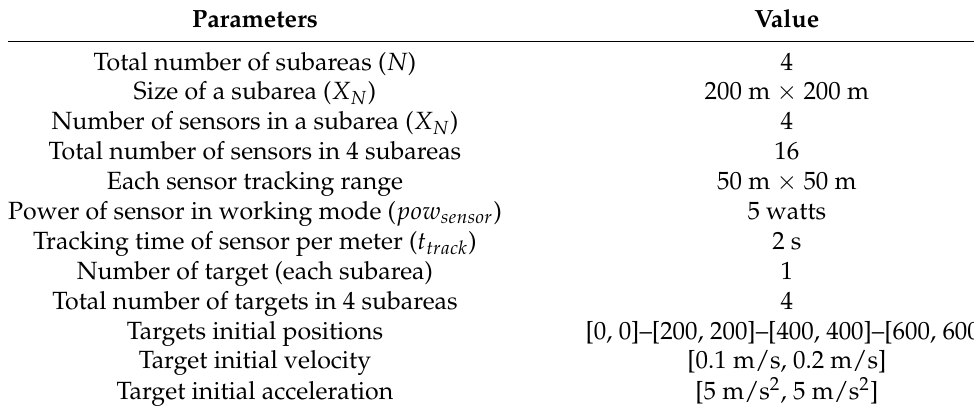
Table 3. Details of the proposed environment.